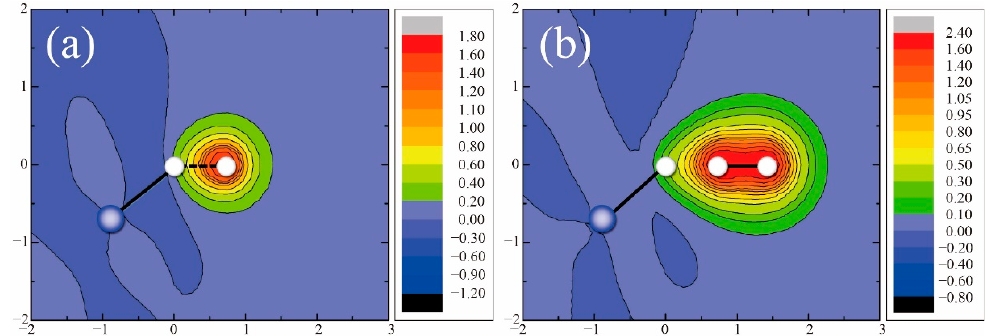
Figure 2. (Color online) The difference of the charge densities between the hydrocarbon chain with H ( a ) or H 2 ( b ) adsorbed at site s1 and the pristine hydrocarbon chain. The blue and white spheres are the carbon and hydrogen atoms, respectively.